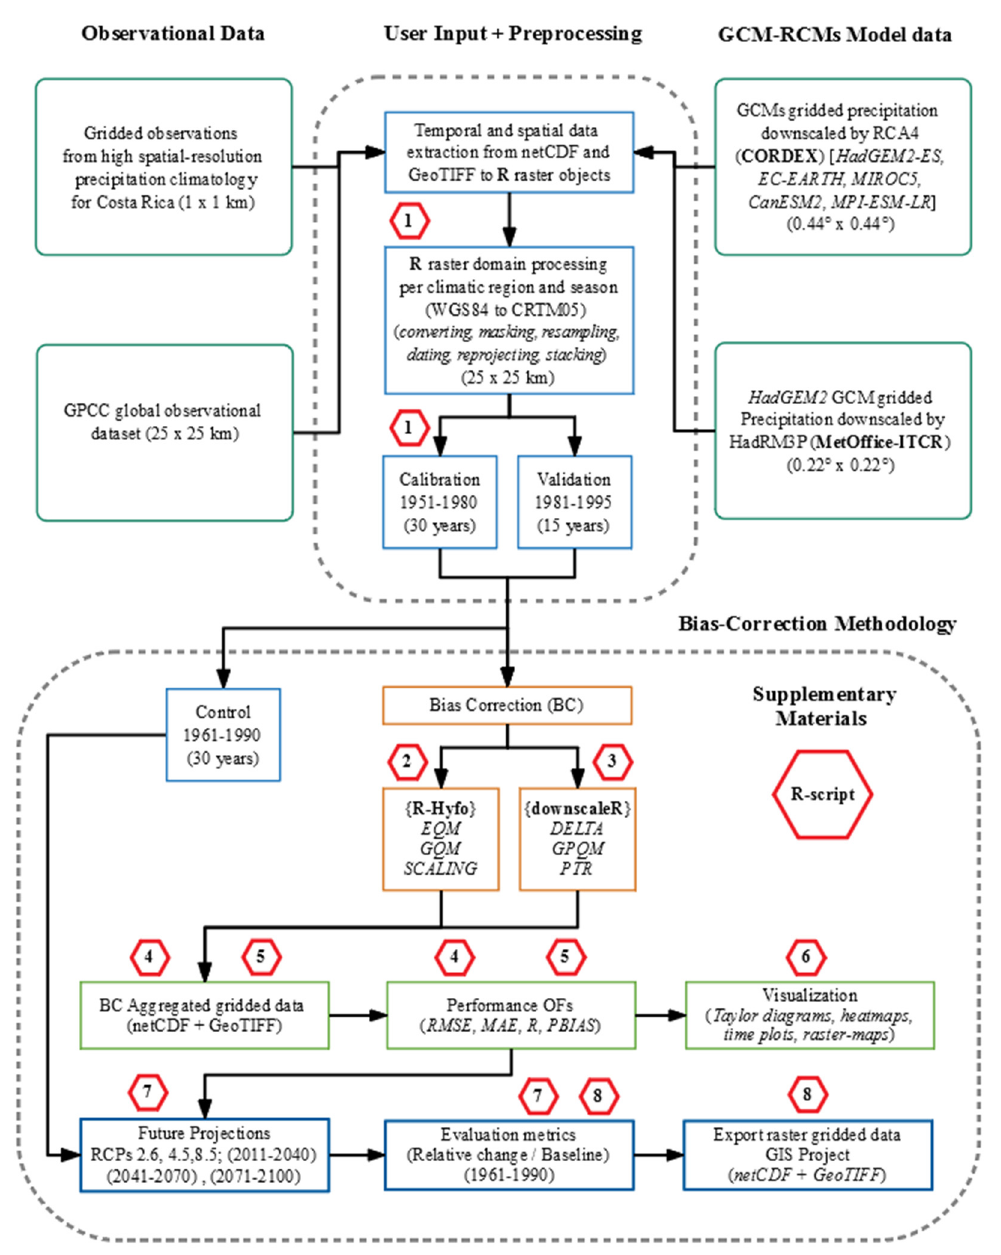
Figure 3 . Flowchart of data processing and implementation of the bias correction (BC) methodology utilized. Hexagons represent the corresponding R-script included in Supplementary Materials.